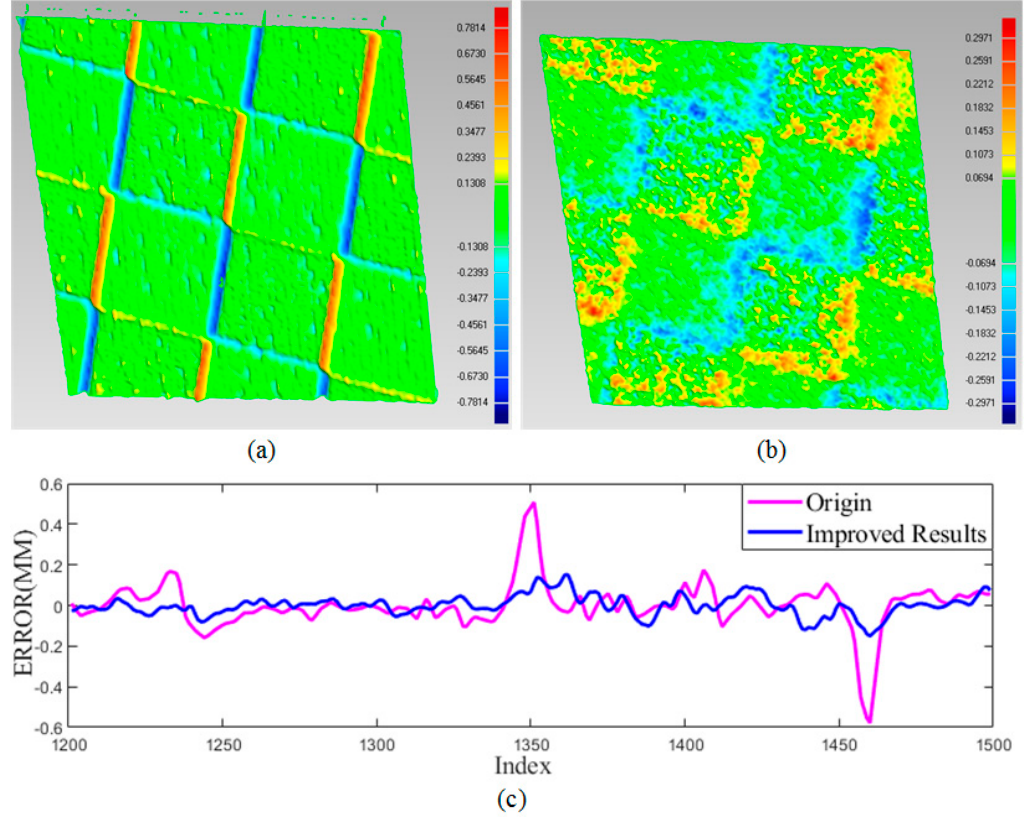
Figure 8. Comparisons and results of a checkerboard. ( a ) The result by [42]; ( b ) The result by ours; ( c ) The errors from the same row in the camera image. Table 1. Comparisons of reconstruction results